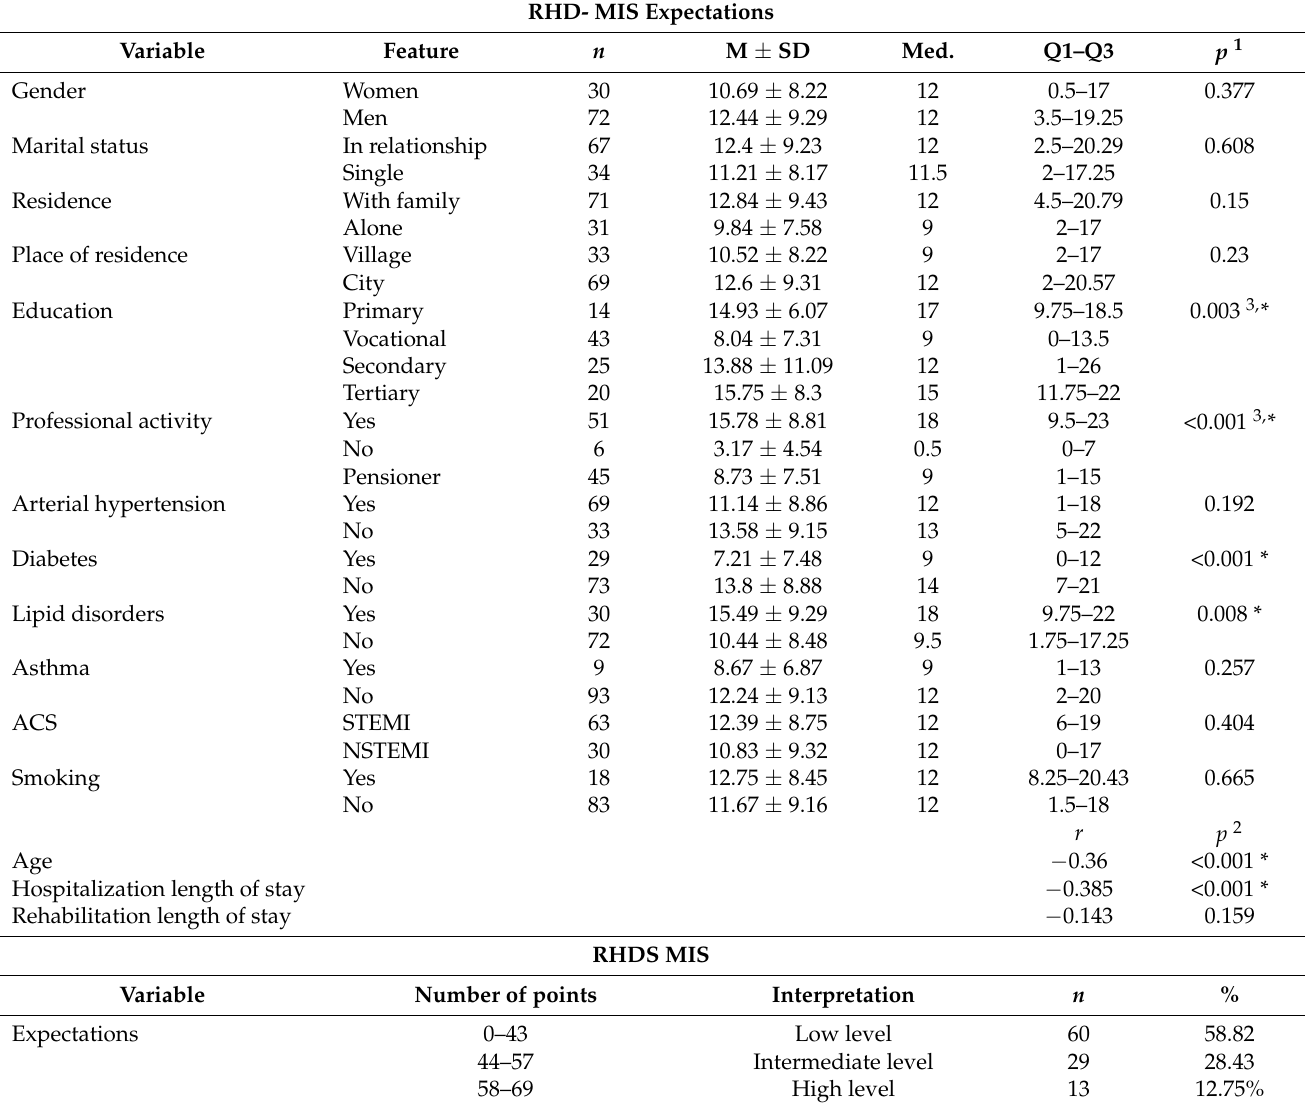
Table 5. Effects of socio-demographic and clinical variables on expectations in MI